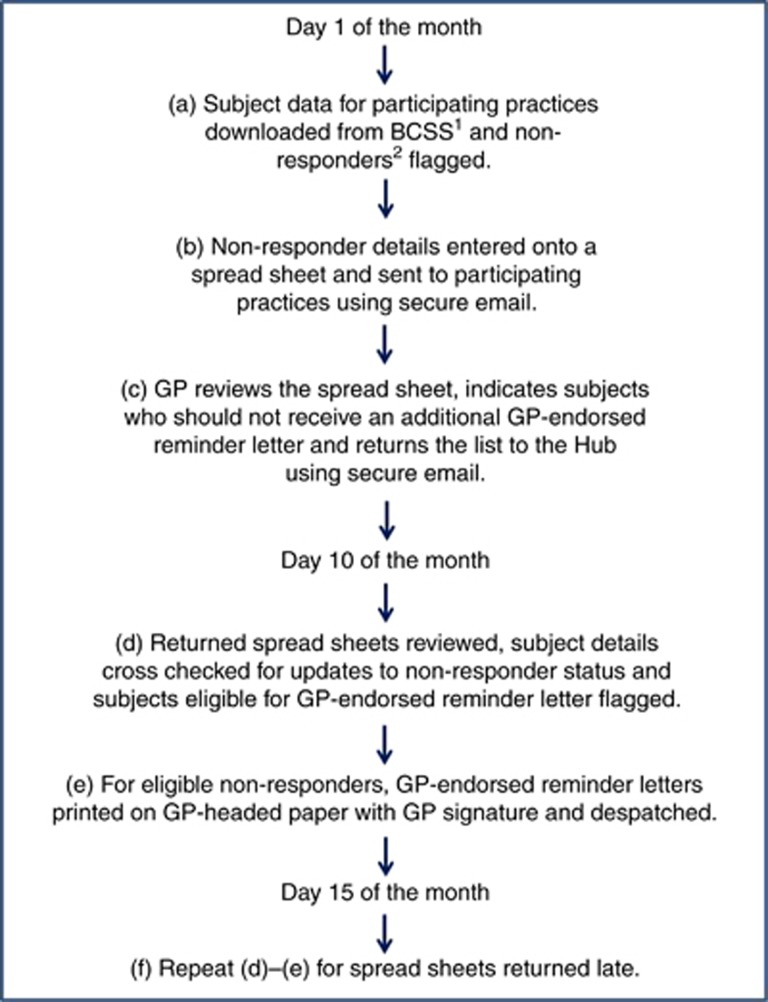
Schematic representation of PEARL process.
1BCSS: Bowel Cancer Screening System; 2Non-responders defined as subjects who had not returned a test kit within 30–60 days of a standard reminder letter.